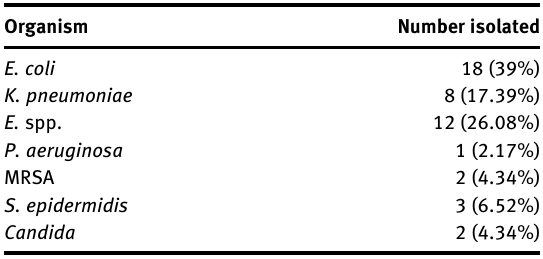
Table  : ListofGram-negativeorganismisolatedfromcontrol group